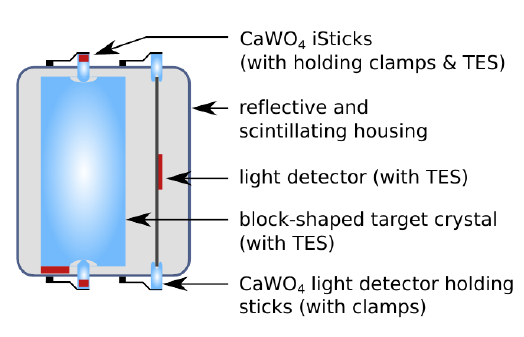
Figure 1: Schematic side view of Det-A operated in CRESST-III. Figure from Ref. [ 28 ] 1